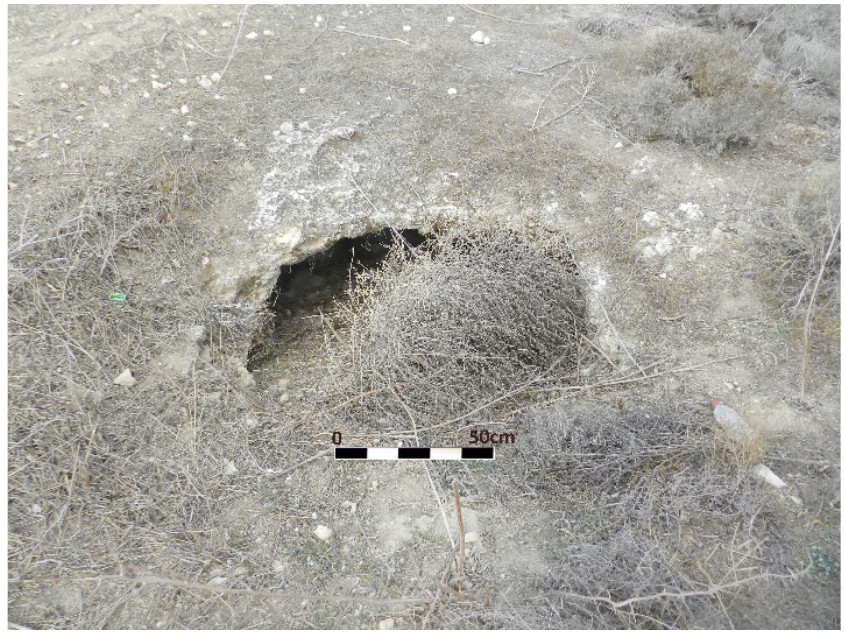
Figure 15. A looted rock-cut tomb at the site of Kophinou-Panagia, most probably of the Iron Age (Image by Athanasios K. Vionis).